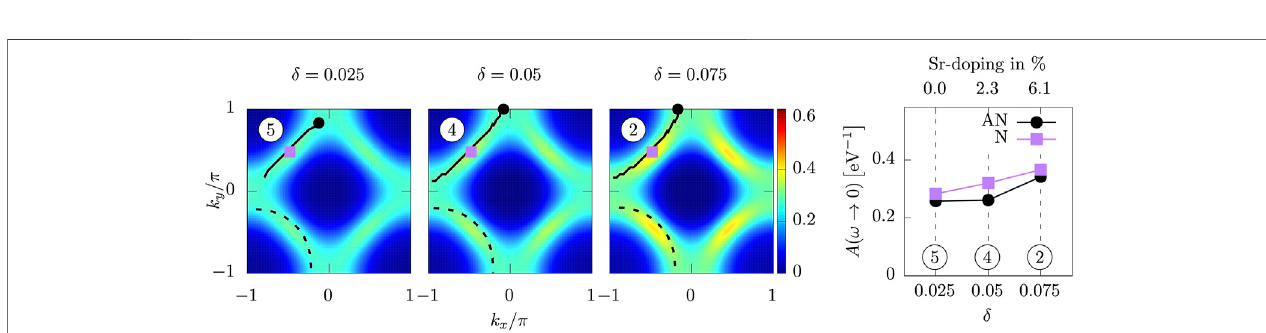
FIGURE 4 | Analogous plots to Figure 3 at fi xed T = 920 K for dopings 2.5%, 5%, and 7.5%.